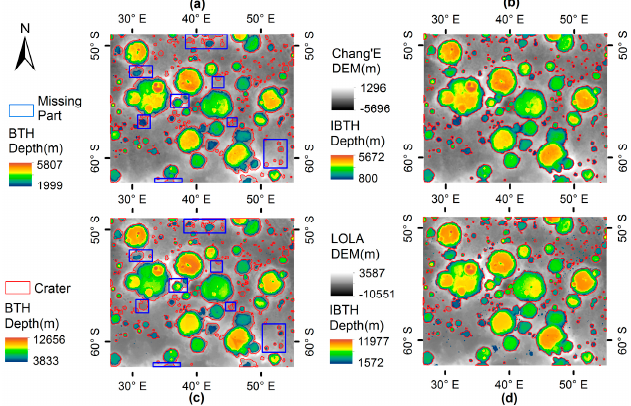
Figure 6. Crater depth estimates for the tested area located in LQ-27on the Moon. ( a ) Crater depth extracted by BTH based on Chang’E DEM. In comparison to the IBTH method, the red boundary of craters indicates the missing crater rim that BTH did not detect and the blue rectangles point out the missing craters that BTH did not recognize; ( b ) crater depth extracted by IBTH based on Chang’E DEM; ( c ) crater depth extracted by BTH based on LOLA DEM. In comparison to the IBTH method, the red craters boundary indicates the missing crater rim that BTH did not detect and the blue rectangles point out the missing craters that BTH did not recognize; ( d ) crater depth extracted by IBTH based on LOLA